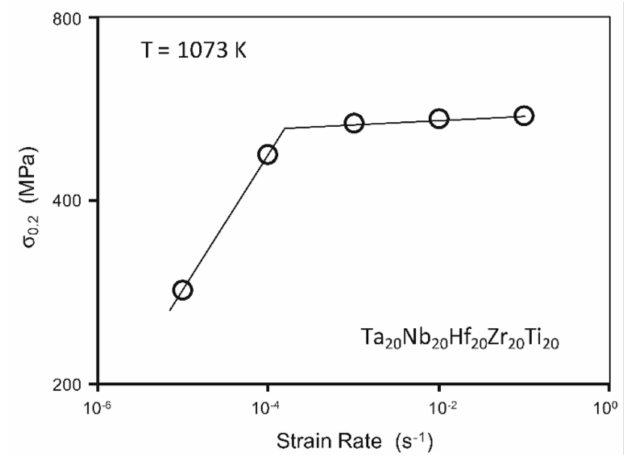
Figure 32. The “yield strength–strain rate” curve of high-entropy TaNbHfZrTi alloy at 1073 K, plotted from the data in Table 4. Reprinted with permission from ref. [50]. Copyright 2012 Springer